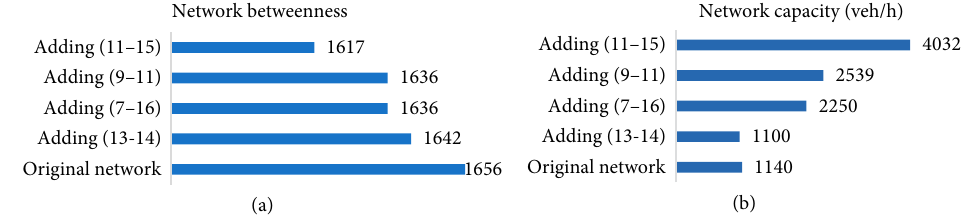
Figure 10: Change of two different indexes with the strategy of choosing new links. (a) network betweenness; (b) network